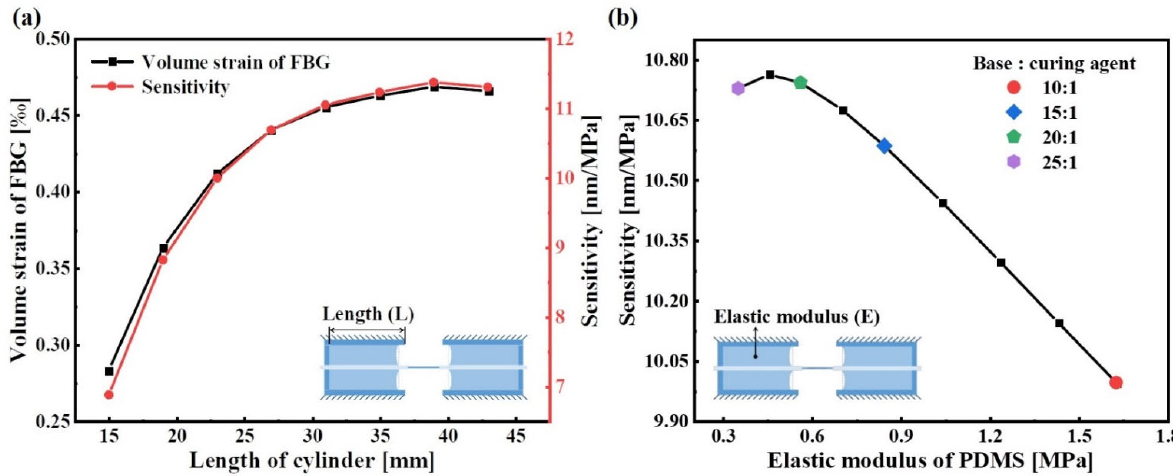
Figure 8. Parameter analysis of the sensor with 10 mm inner diameter: ( a ) the relationship between the measurement sensitivity and the length of the cylinder; ( b ) the relationship between the measurement sensitivity and the elastic modulus of the PDMS.